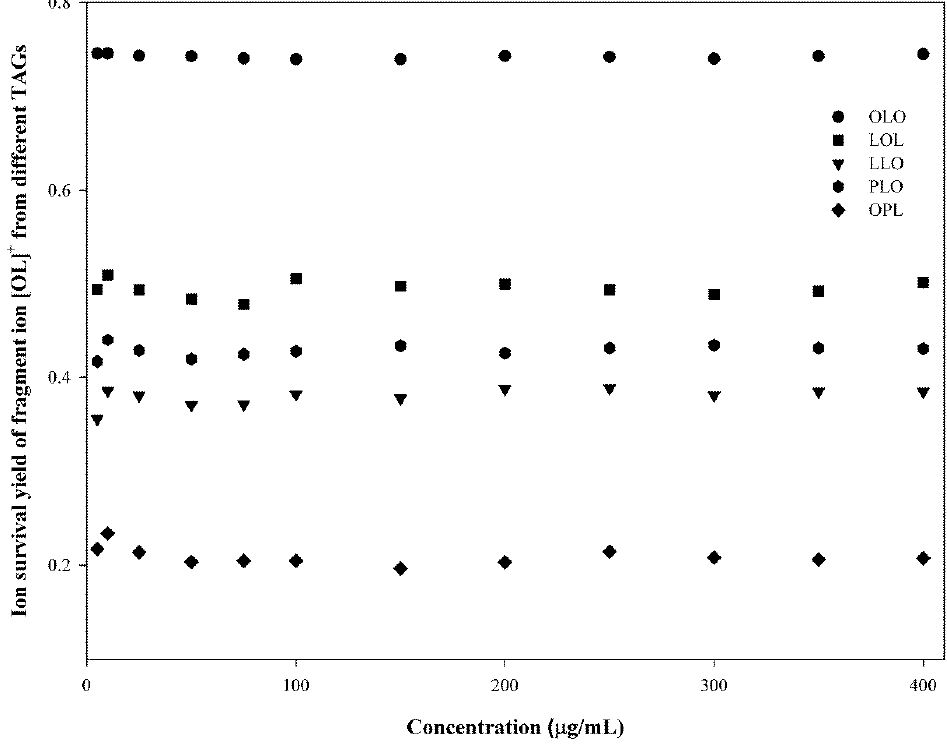
Figure 5. Ion survival yields (ISYs) for the fragment ion [OL] + from representative TGs over the concentration range